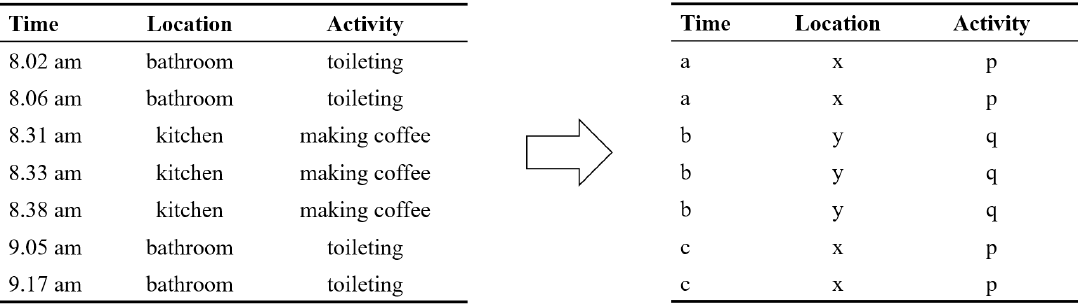
Figure 2. Representation of Table 1 in ASCII characters and processed based on 30 min time